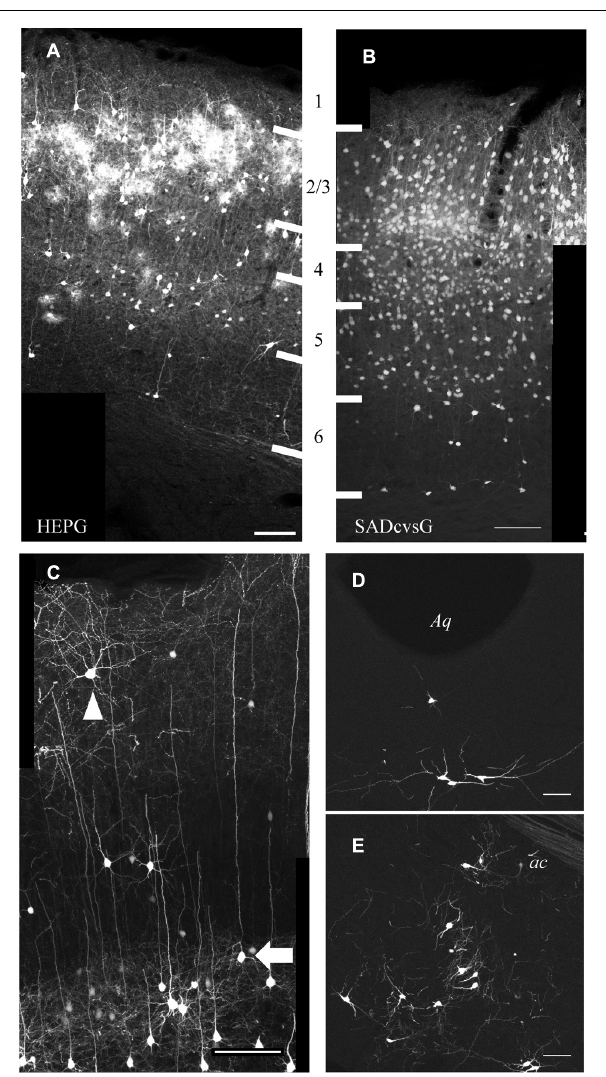
FIGURE 6 | Presynaptic cells traced from layer 2/3 pyramidal neurons. Distribution of cortical cells traced with HEPG (A) and SADcvsG (B) .The white thick lines indicate laminar boarders and the numbers between (A) and (B) indicate cortical layers. (C) Example of rabies tracing with SADcvsG. Slender-tufted pyramidal neurons (arrow), but few thick-tufted, were often traced as presynaptic partners in layer 5. Non-pyramidal neurons (arrowhead) were also traced. (D) Serotonergic neurons in the dorsal raphe nucleus near Aqueduct (Aq). (E) Cholinergic neurons in the